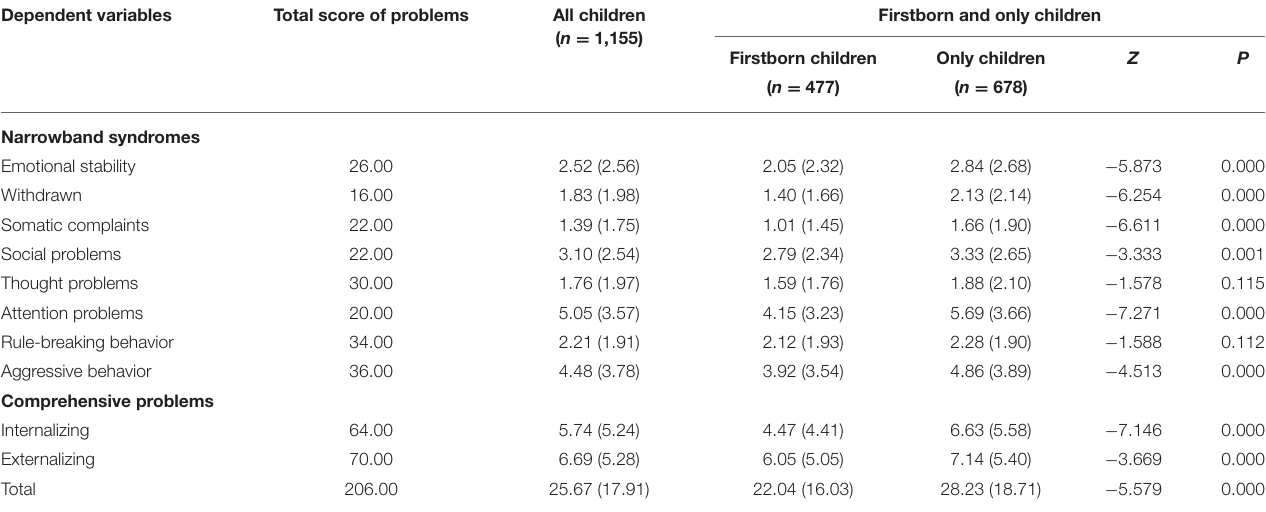
TABLE 2 | Comparison of emotional and behavioral scores between firstborn children and only children, Mean (SD), Rank sum test. Dependent variables Total score of problems All children ( n =